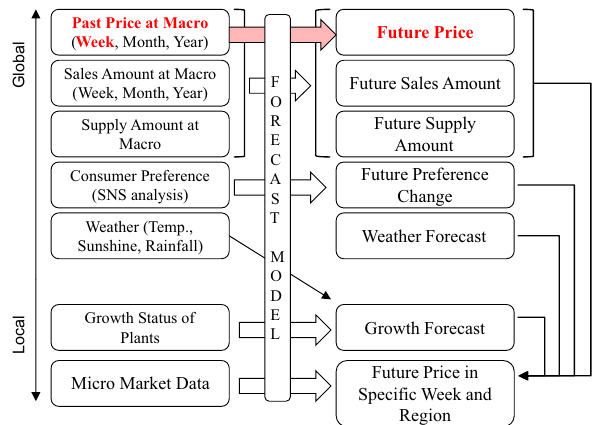
Fig. 1 Whole forecasting framework. Upon receiving the past price time series, sales and supply amount, consumer preference, weather, and so on, the forecast model generates the future values. In this paper, we only worked with market price data shown in